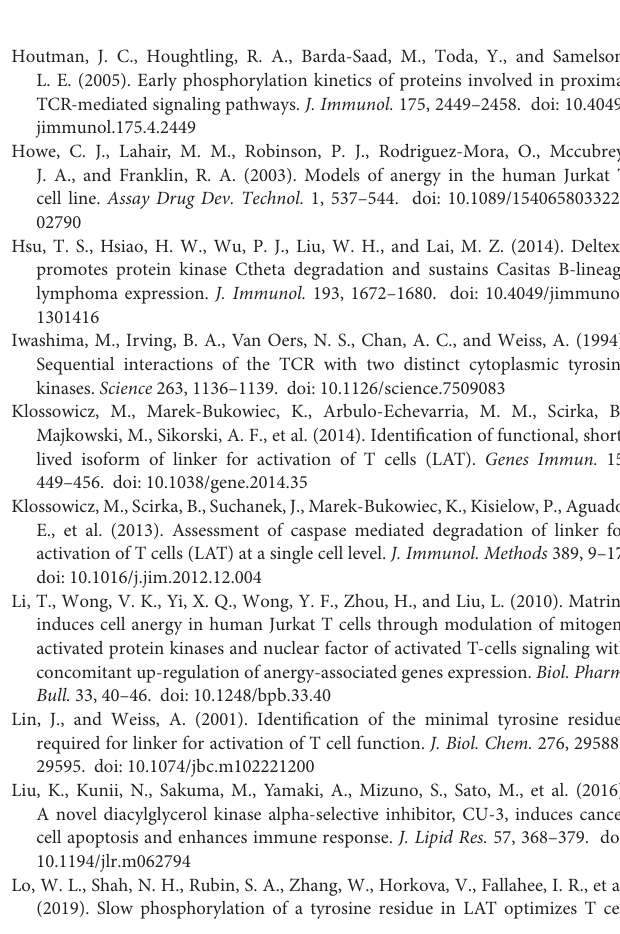
FIGURE S1 | Expression of WT-LAT and LAT G131D in J.CaM2 cells. (A) Schematic representation of the lentiviral vectors used to express WT-LAT and the LAT G131D mutant in J.CaM2 cells. (B) Histograms of GFP and CD3 expression in lentivirally transduced J.CaM2 cells expressing WT-LAT (green line) or LAT G131D mutant (black line). Numbers in the histograms represent the percentage of positive cells.